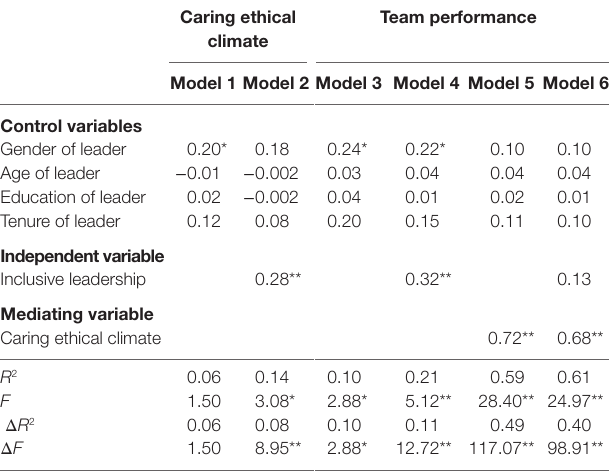
TaBle 5 | Results of hierarchical linear analysis of inclusive leadership and employee voice behavior.